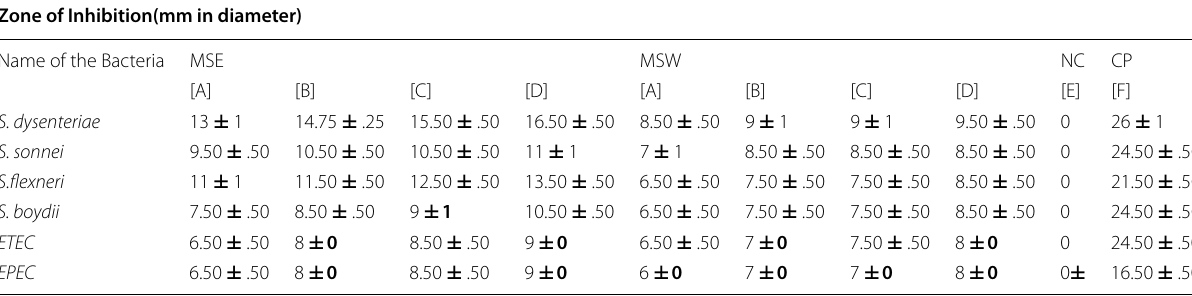
Table 4 The zone of inhibition of different conc. of 2 MM extracts on some pathogenic bacteria Zone of Inhibition(mm in diameter) Name of the